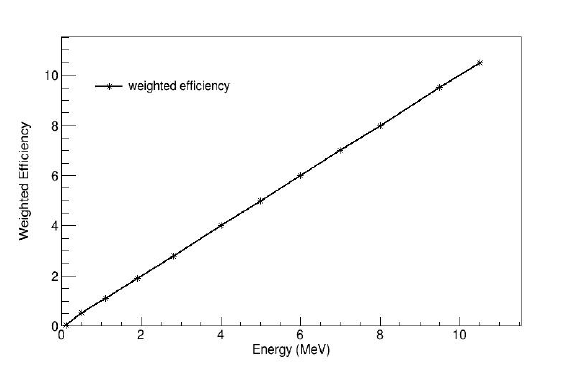
Fig.8 The weighted detective efficiency of the C 6 D 6 detector.